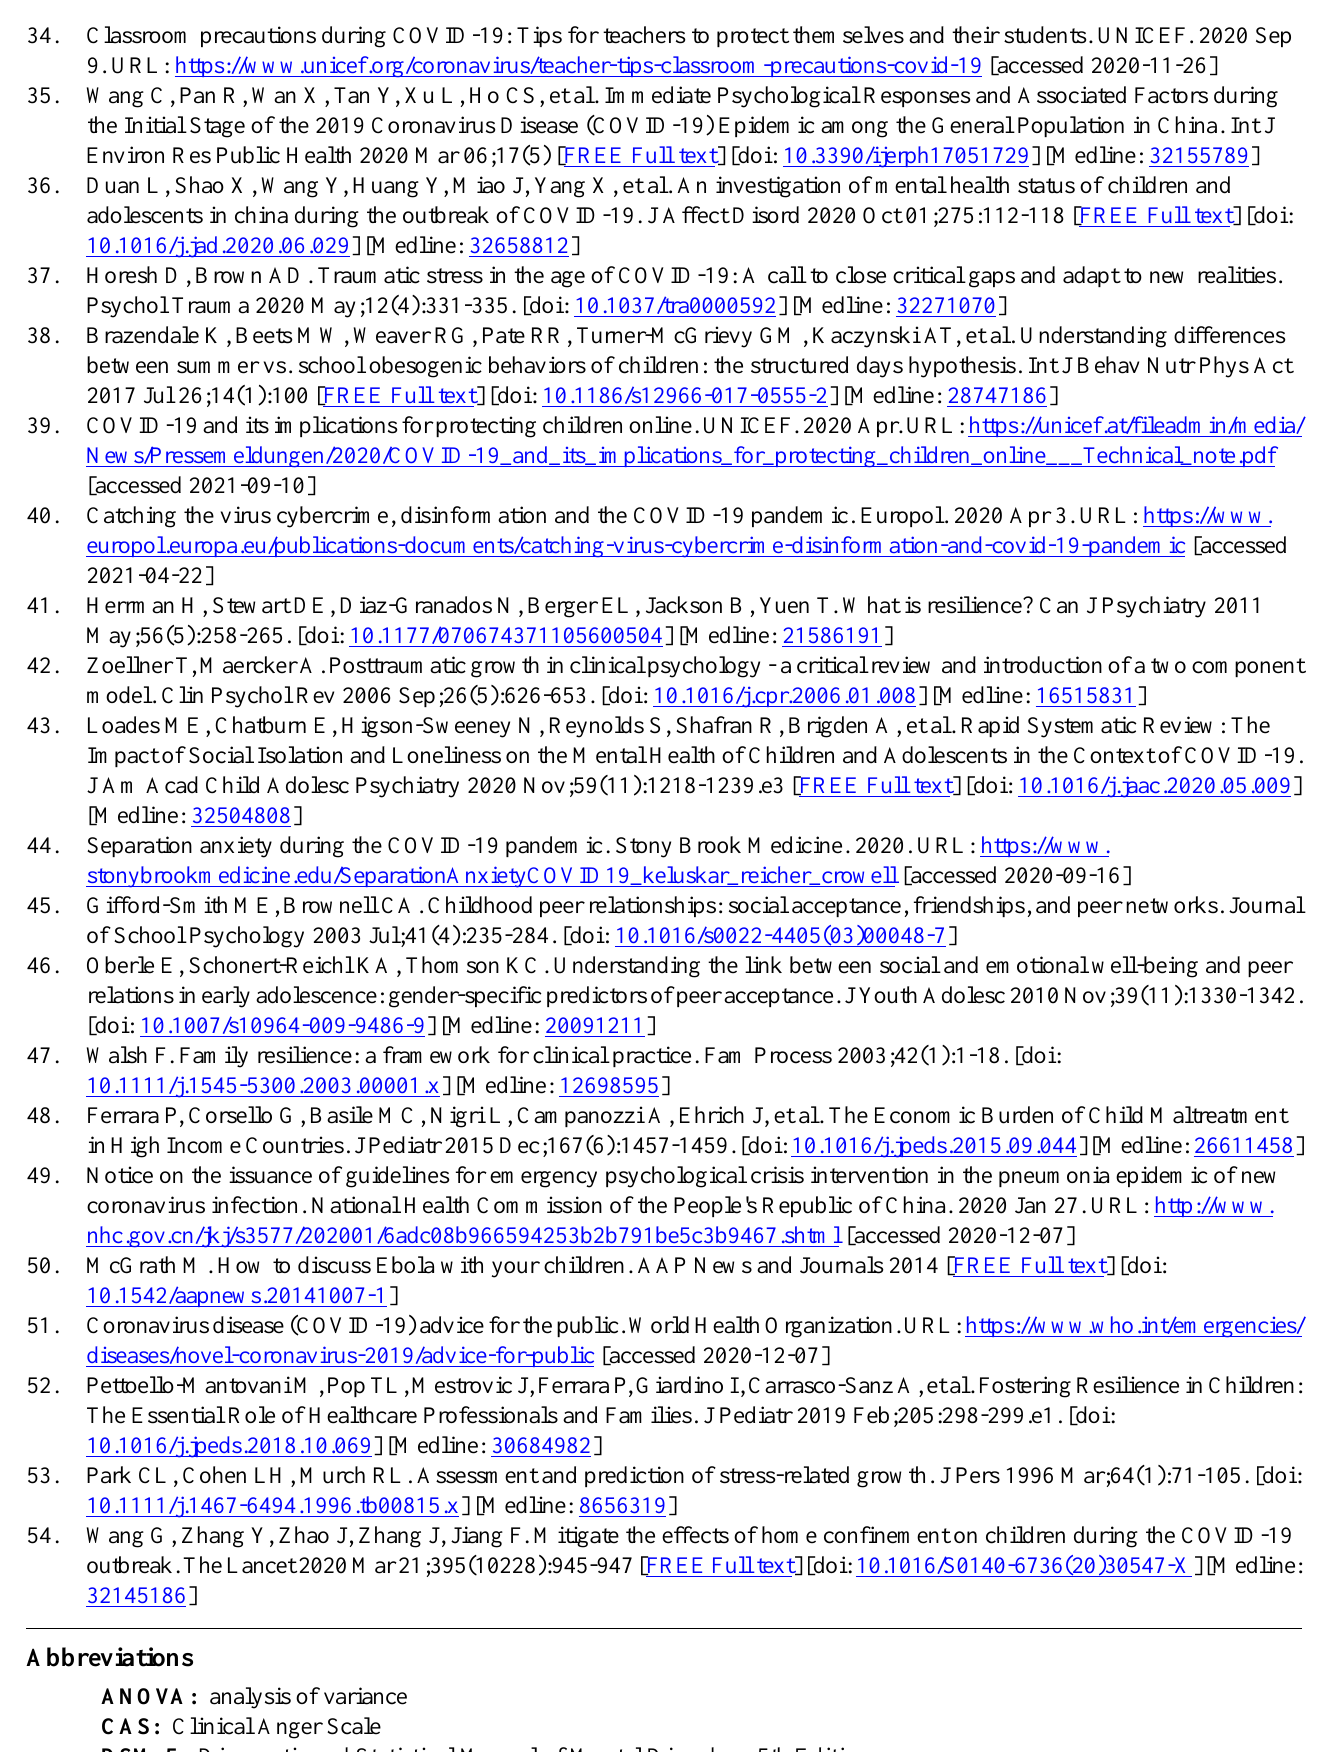
DSM-5: Diagnostic and Statistical Manual of Mental Disorders, 5th